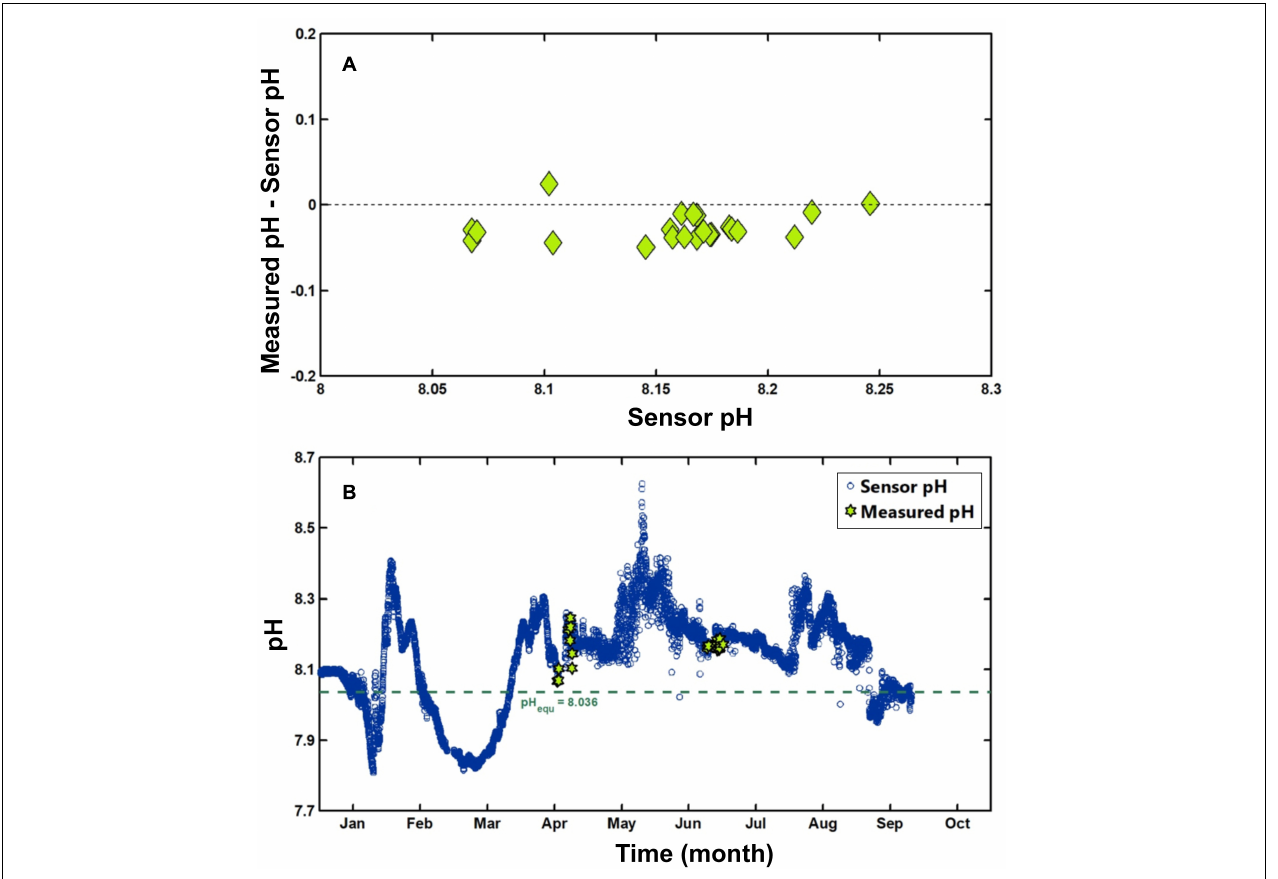
FIGURE 11 | (A) Comparison between sensor-based pH measurements (senor pH) and spectrophotometric pH values (measured pH) on the same set of discrete samples. (B) Continuous pH measurements made at Ieodo ORS from January to September 2019. The green dashed line indicates a pH value in equilibrium with the concurrent global mean atmospheric pCO 2 of 412 ppm. Green stars indicate discrete pH data based on spectrophotometry using m-cresol